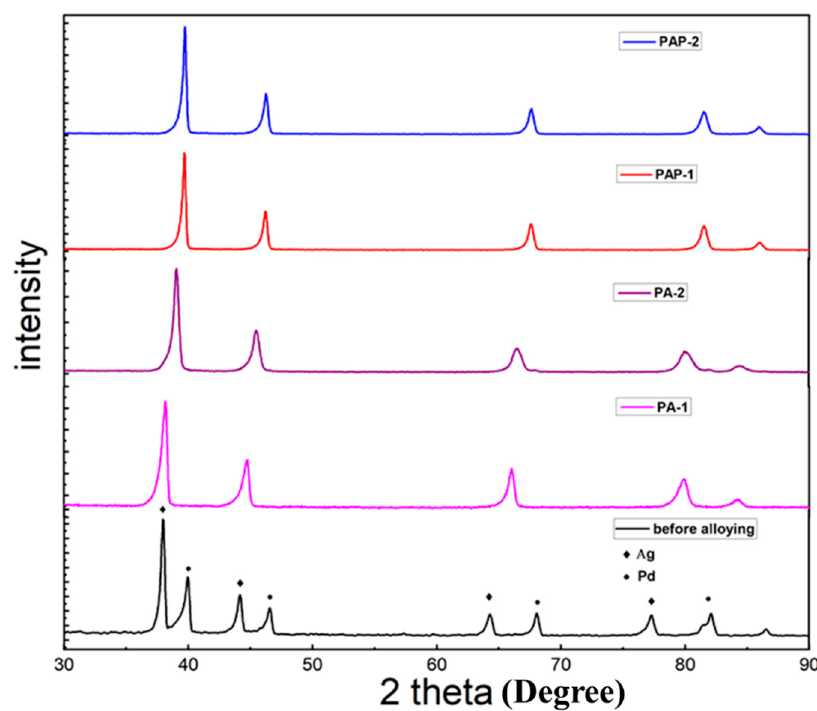
Figure 2. X-ray diffraction (XRD) patterns of PA-1 before alloying; PA-1, PA-2, PAP-1 and PAP-2 after annealing treatment at 823 K for 24 h.